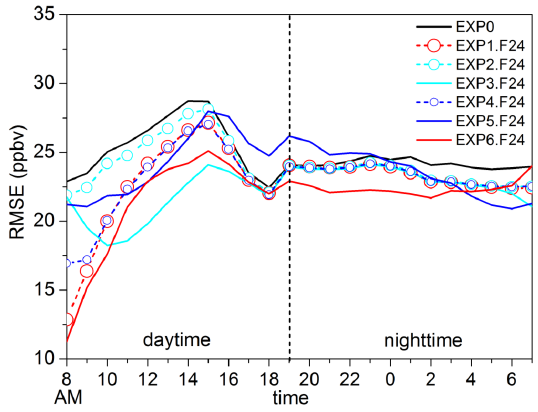
Fig. 12. Daily variation of the RMSEs of ozone forecast in the six 24-hour forecast experiments (EXP1.F24, EXP2.F24, EXP3.F24, EXP4.F24, EXP5.F24, EXP6.F24) and those in free run EXP0.